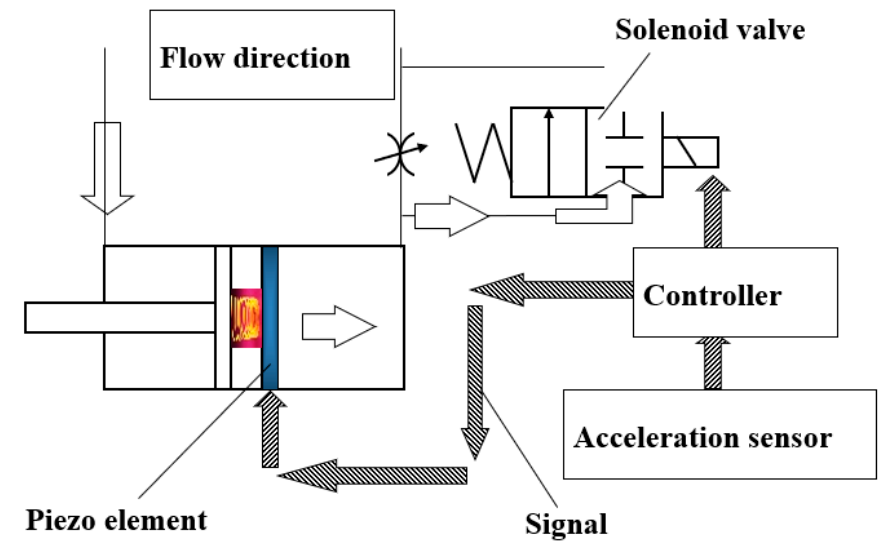
Figure 6. Pneumatic circuit diagram (when shocked) .